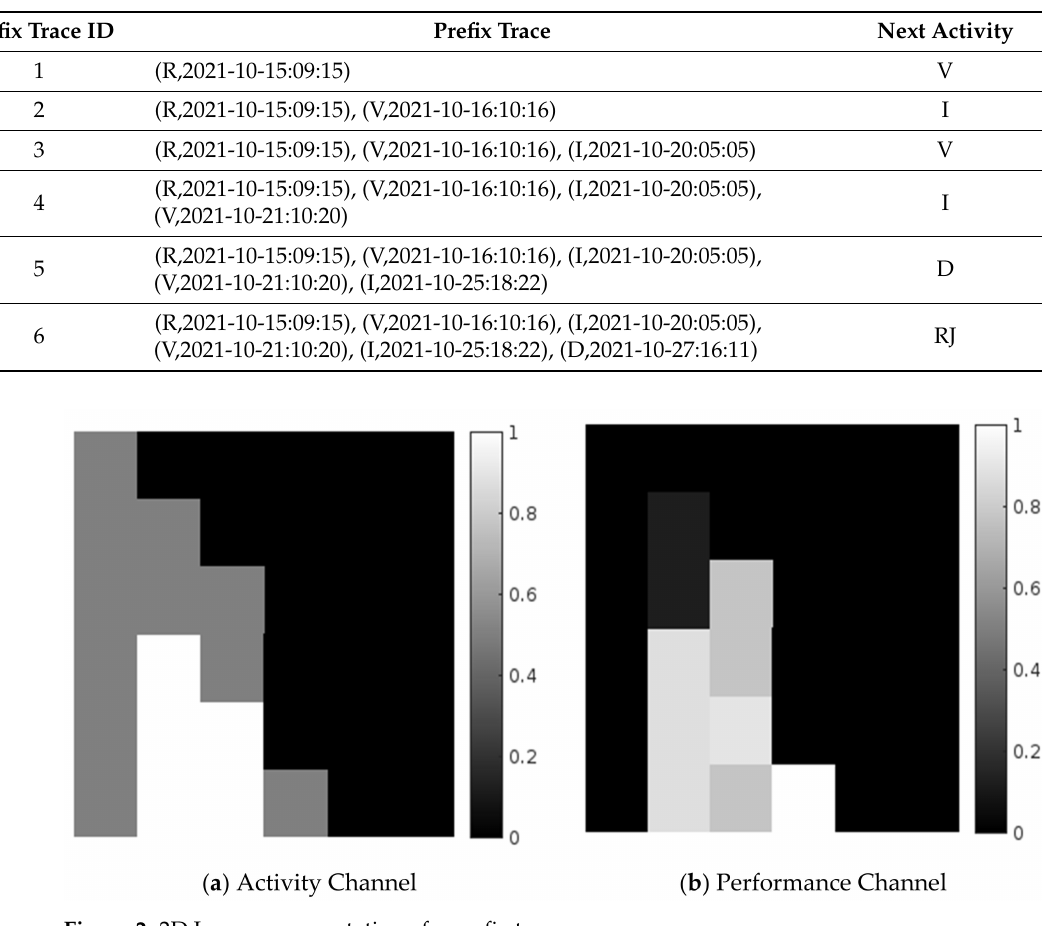
Figure 2. 2D Image representation of a prefix